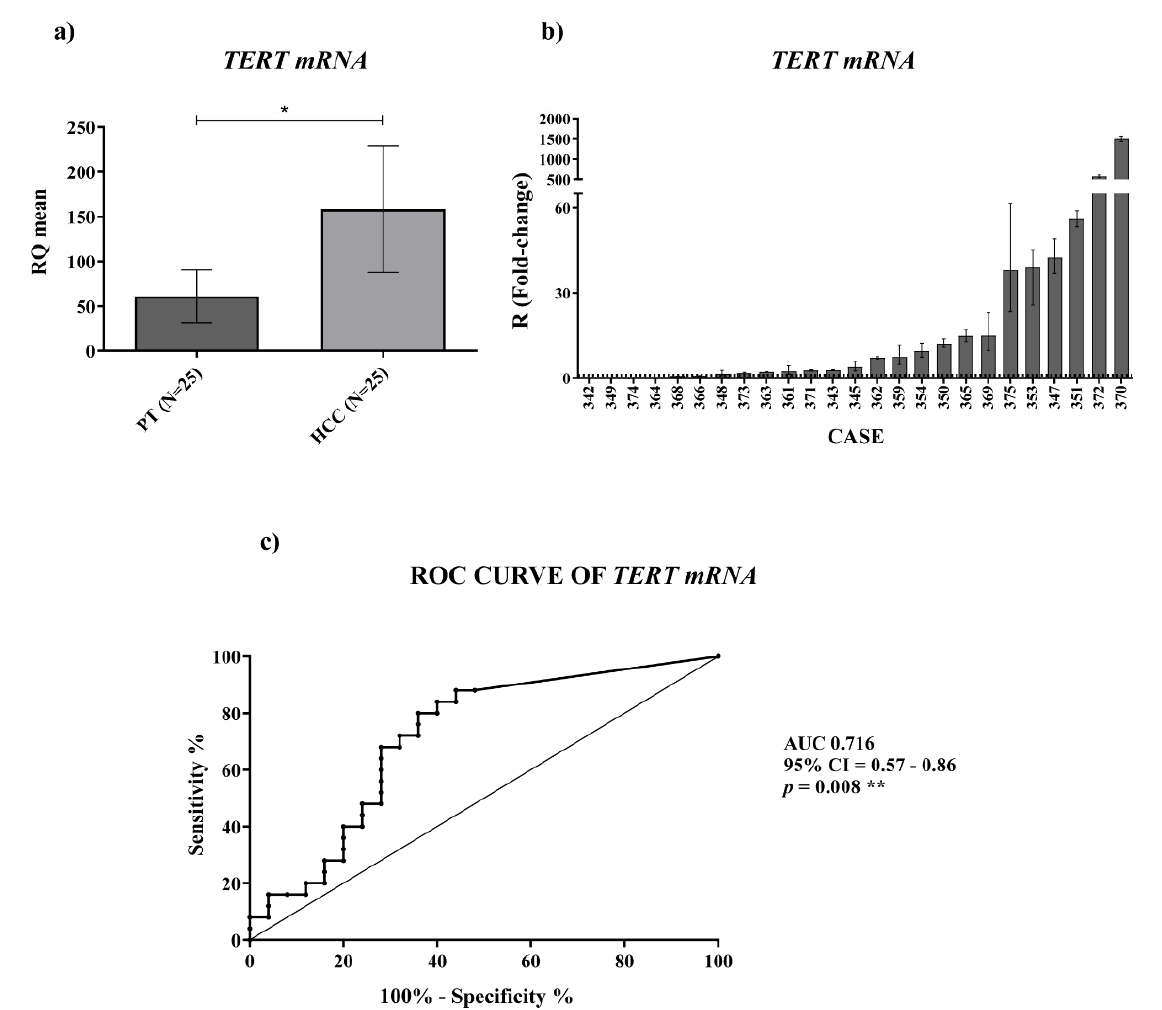
Figure 3. Tissue expression of TERT mRNA. ( a ) TERT mRNA relative quantification mean comparison between PT and HCC. Wilcoxon test was used. ( b ) TERT mRNA fold-change. Histograms represent R-values and bars upper and lower limits. Histograms are ordered by increasing R-values. The corresponding cases are listed on x axis. Upper and lower dot lines define the range of gene expression variation. ( c ) ROC curve analysis to discriminate HCC from normal tissue. AUC: area under the ROC curve; CI: confidence interval. * p < 0.05; ** p < 0.01